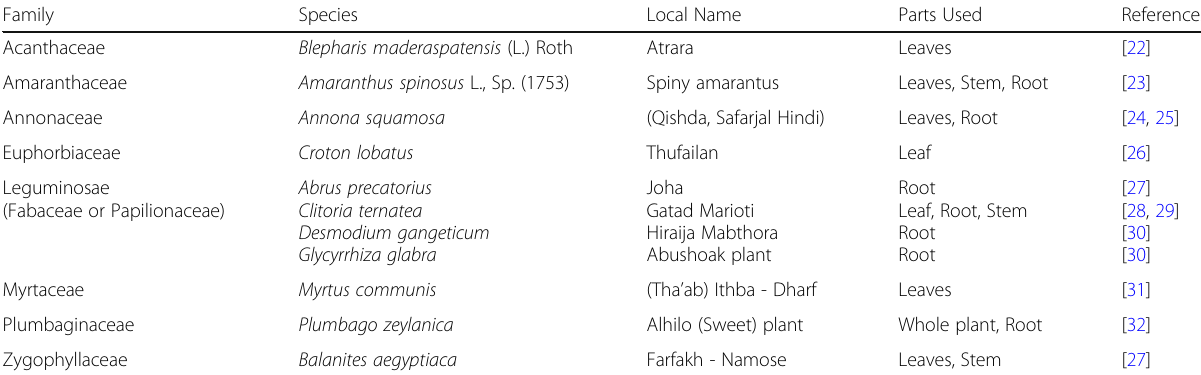
Table 2 Botanical information of 11 endangered medicinal plants in Kingdom of Saudi Arabia Family